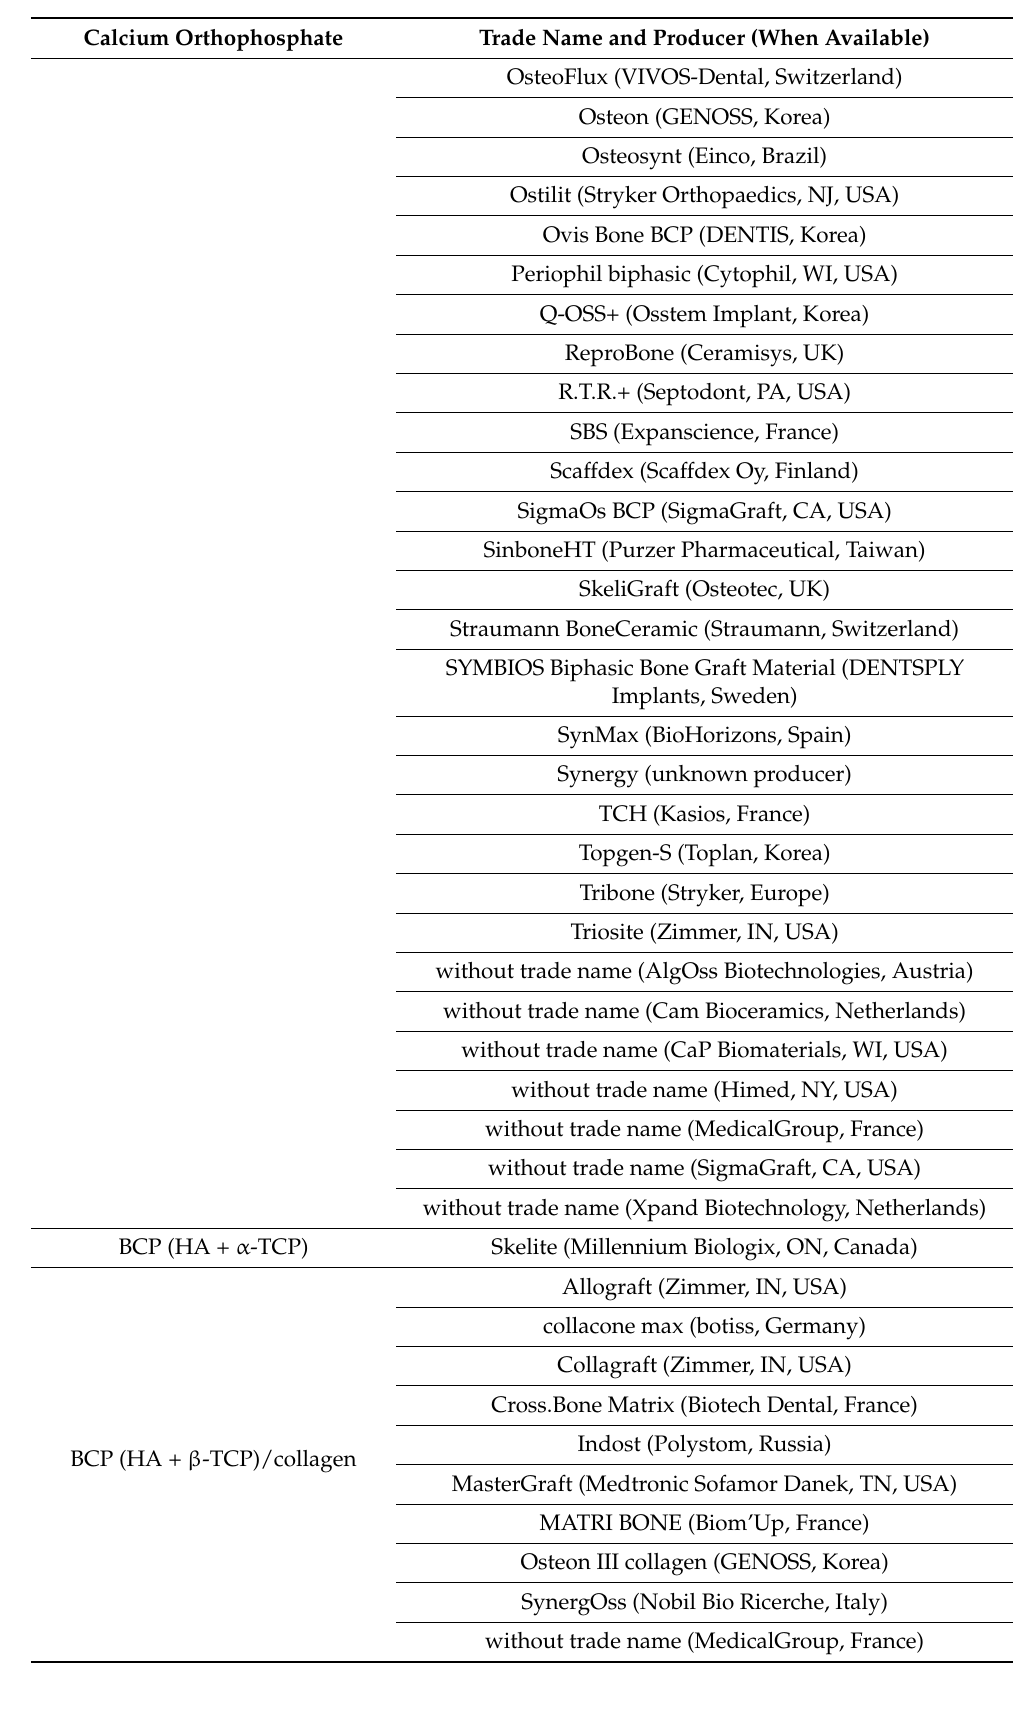
Table 3. Cont . Calcium